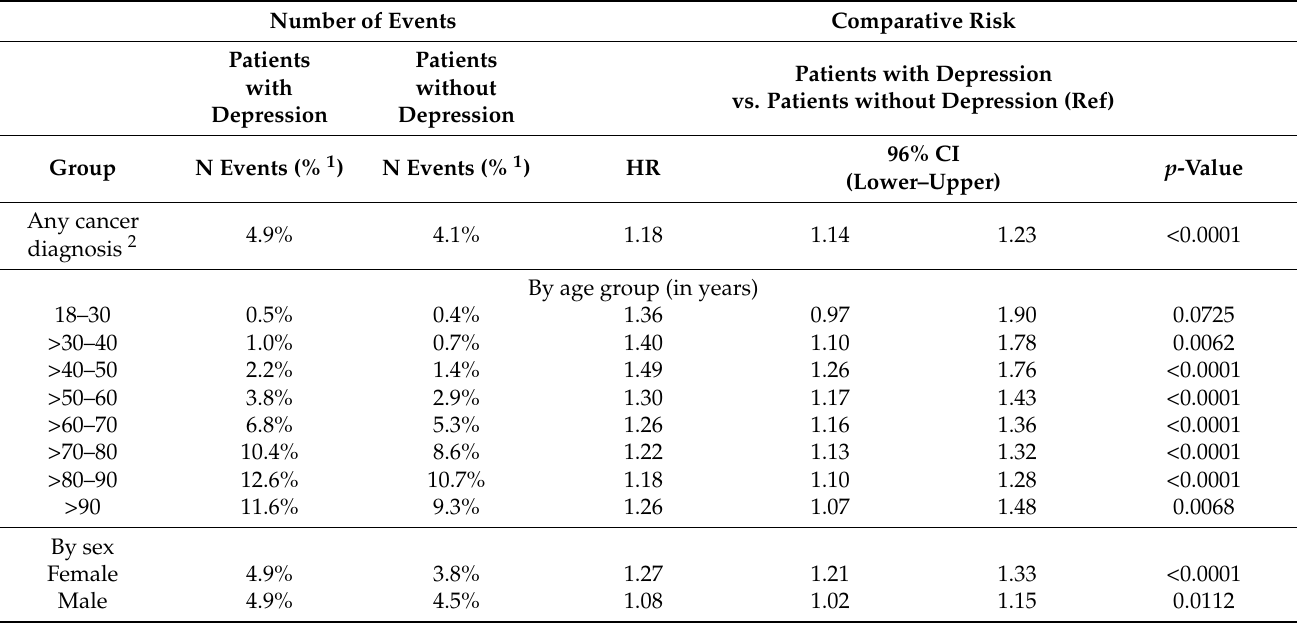
Table 2. Hazard ratio of cancer diagnosis by group, subgroup, and type of cancer. Number of Events Comparative Risk Patients Patients Patients with Depression without vs. Patients without Depression (Ref) Depression